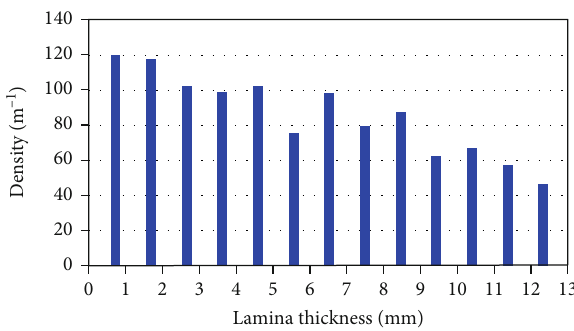
Figure 11: Relationship between density of lamellation fractures and thickness of glauberite lamina in the Qianjiang Depression ( N = 182